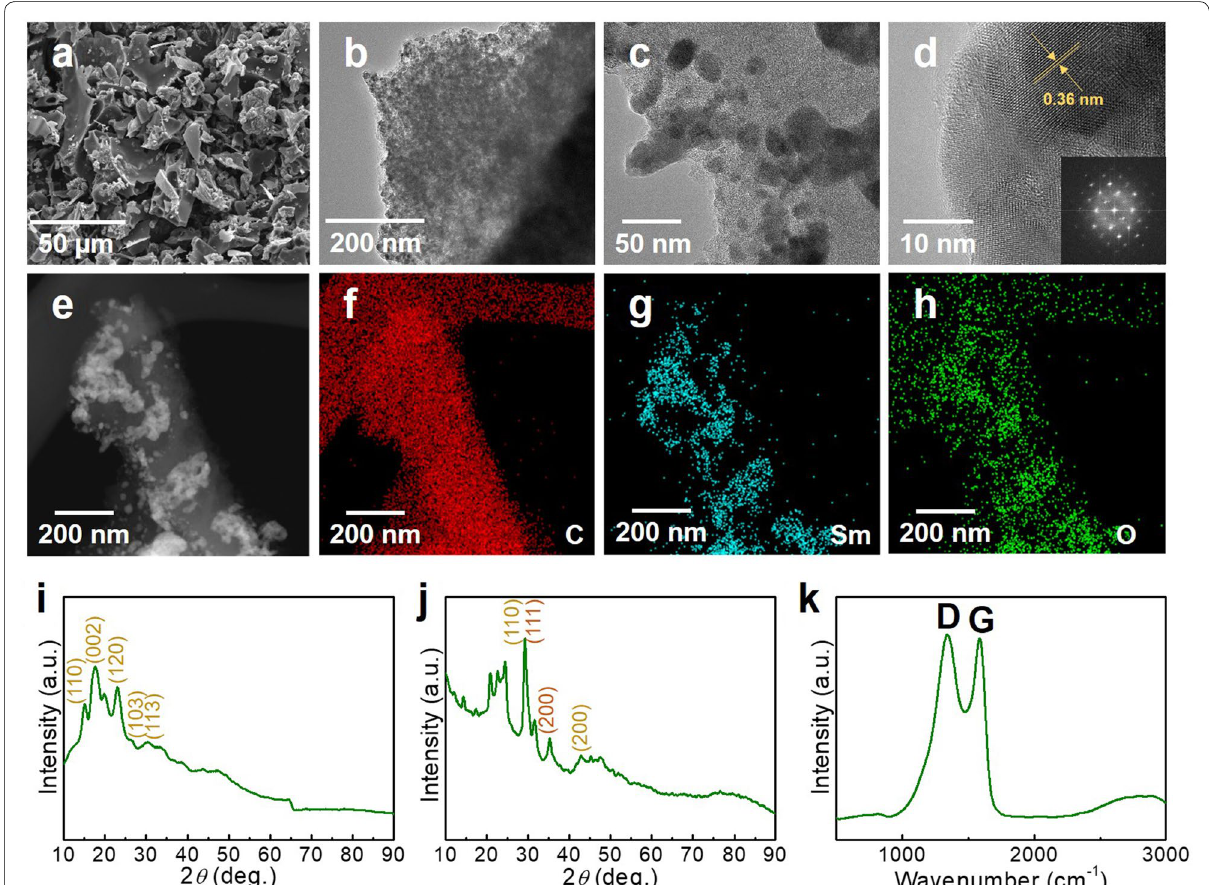
Fig. 2 a SEM, b , c TEM, d HRTEM, e STEM, and f – h EDX mapping images of the SC/Sm. XRD patterns of i SC and j SC/Sm. k Raman spectrum of SC/